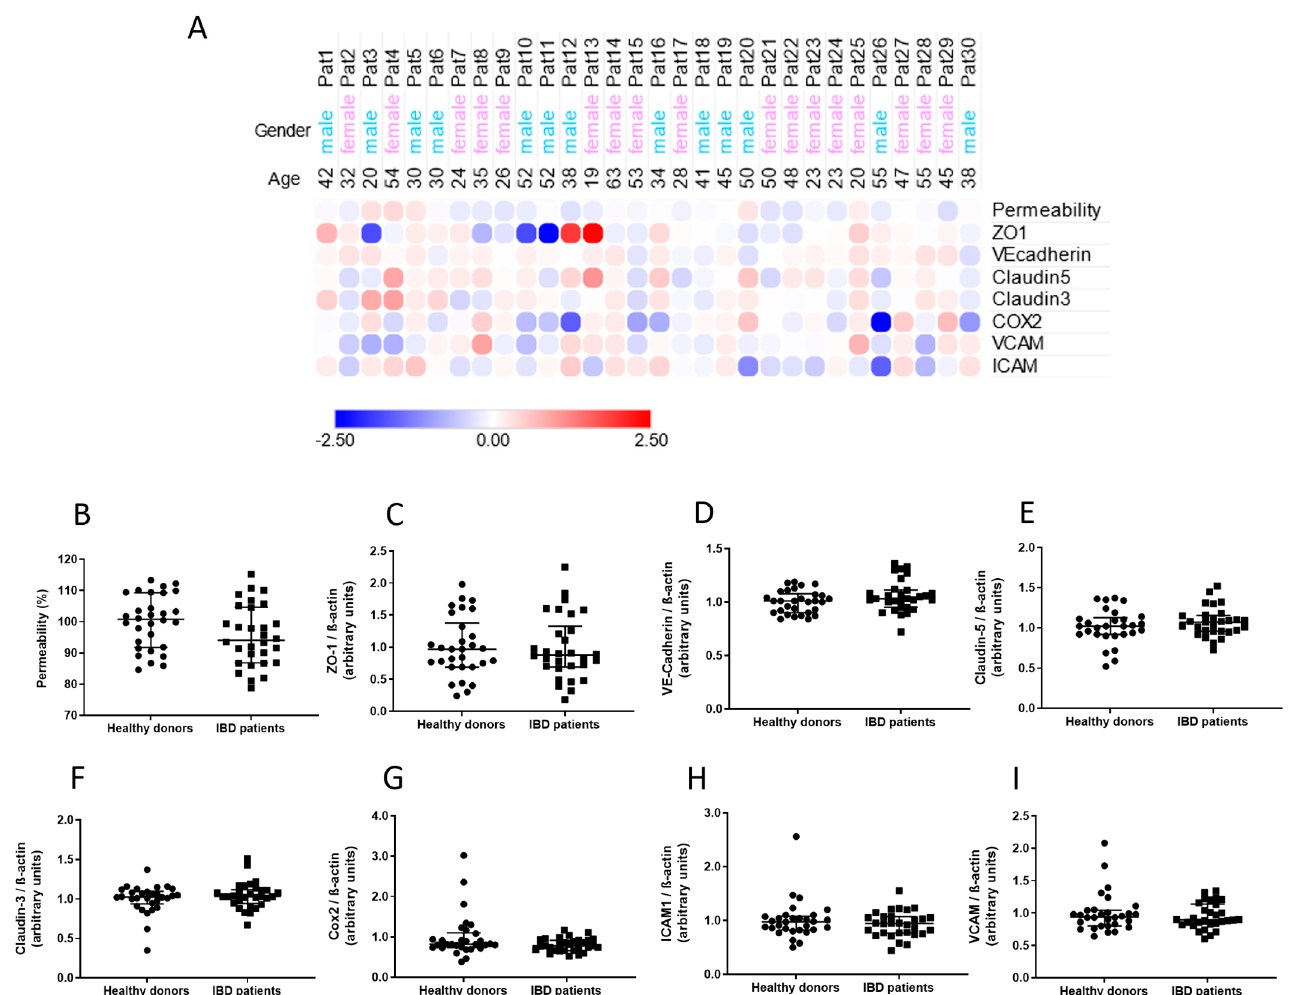
Figure 1. Comparisons between healthy donors and patients of parameters assessed in BLECs treated with donor plasma. Plasma was obtained from n = 30 IBD patients and 30 healthy donors matched by age and sex. BLECs were treated with 10% plasma for 24 h and permeability to NaFlu, and expression of proteins by Western blotting were assessed. An initial comparative analysis of these parameters was carried out, and results are shown as a bubble heatmap evidencing log2 fold-changes of assessed parameters for IBD patients in comparison to healthy donors (log2 fold-change magnitude represented in the bar below the graph) ( A ). Further comparisons of paired data were carried out for all parameters assessed: permeability ( B ), expression of junction proteins ( C – F ) and expression of inflammation-related proteins ( G – I ); results are shown as medians alongside interquartile ranges. Comparisons were carried out via Wilcoxon signed rank test. Permeability value of controls = 0.55 ± 0.046 × 10 − 3 cm/min.